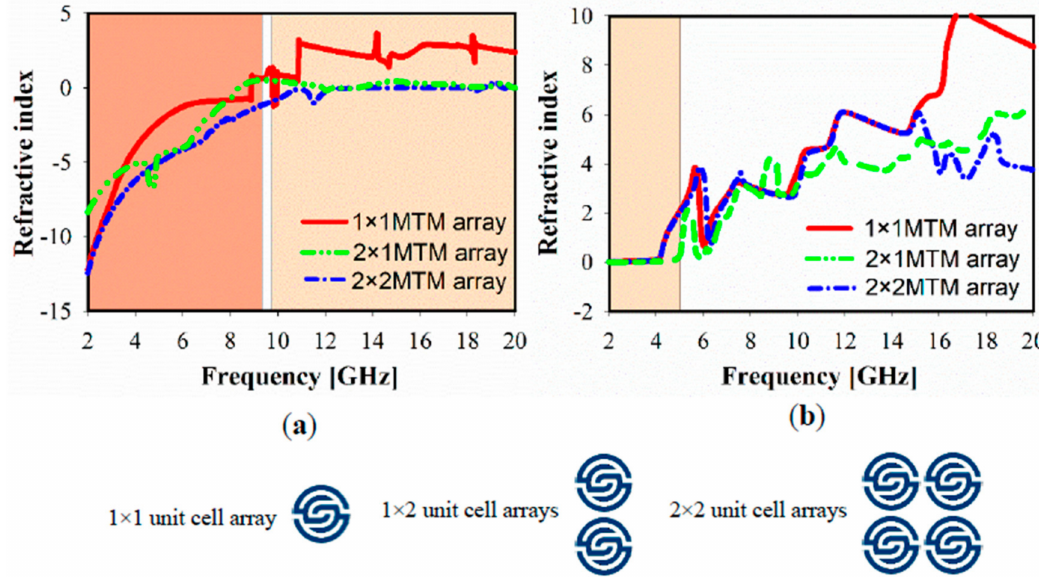
Figure 7. Metamaterial simulated refractive index results of the 1 × 1, 1 × 2 and 2 × 2 array structures: ( a ) x- axis; ( b ) y-